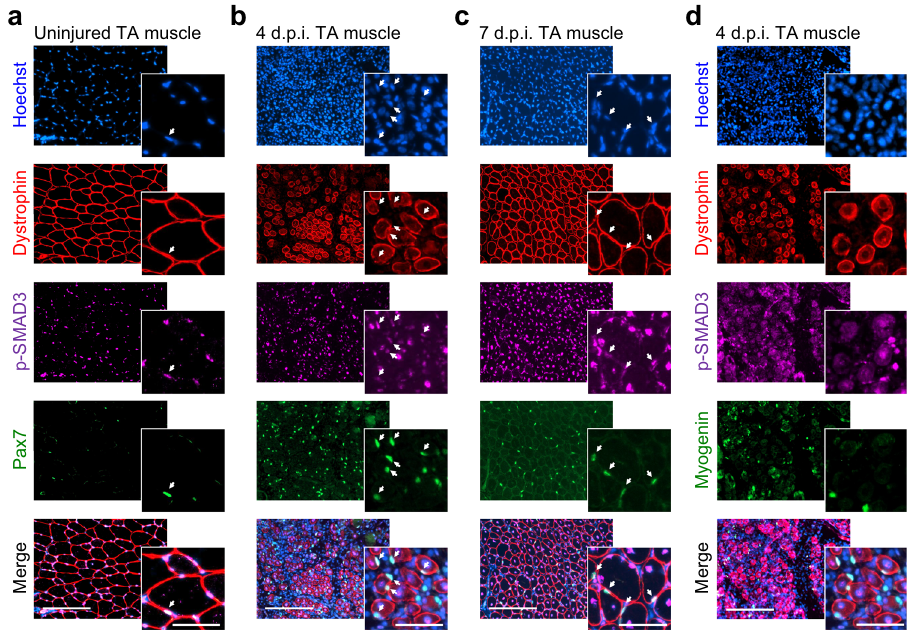
Fig. 2 The state of TGF β signaling during in vivo muscle regeneration. a – c p-SMAD3, PAX7, and DYSTROPHIN immuno fl uorescent stainings on 0-, 4-, and 7-day post injury (d.p.i.) regenerating TA muscle cryosections. SMAD3 signaling is active in interstitial cells and PAX7 + cells (white arrows) during muscle regeneration. p-SMAD3 is strongly expressed by myonuclei of the regenerating myo fi bers marked by DYSTROPHIN at 4 d.p.i. N = 8 cryosections. d p-SMAD3, MYOGENIN, and DYSTROPHIN immuno fl uorescent staining on 4 d.p.i. regenerating TA muscle cryosections. Myocytes do not express p- SMAD3 at the time of differentiation. N = 8 cryosections. Scale bars: low magni fi cation, 400 μ m; high magni fi cation, 100 μ